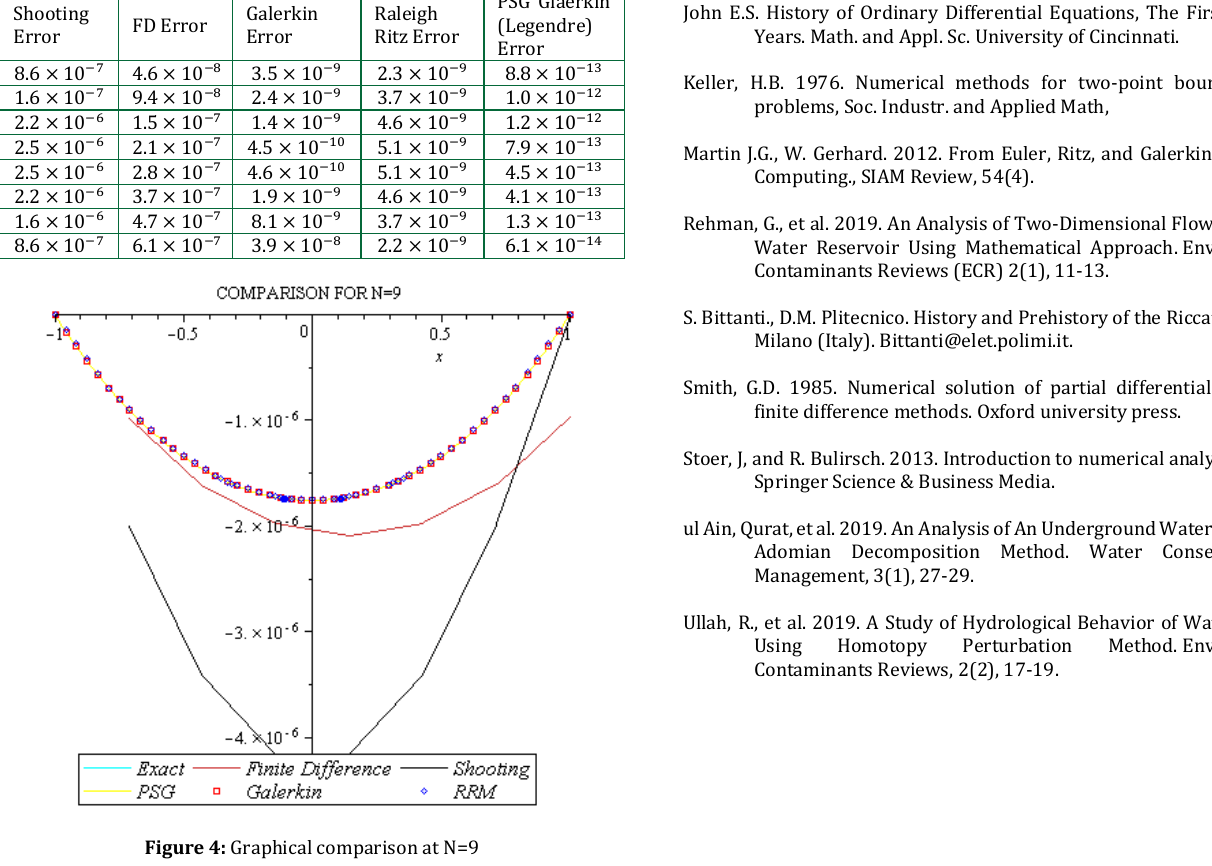
Figure 3: Graphical comparison at N=7 The following error table consists of value for N=9. Table 3: Comparison table for N=9